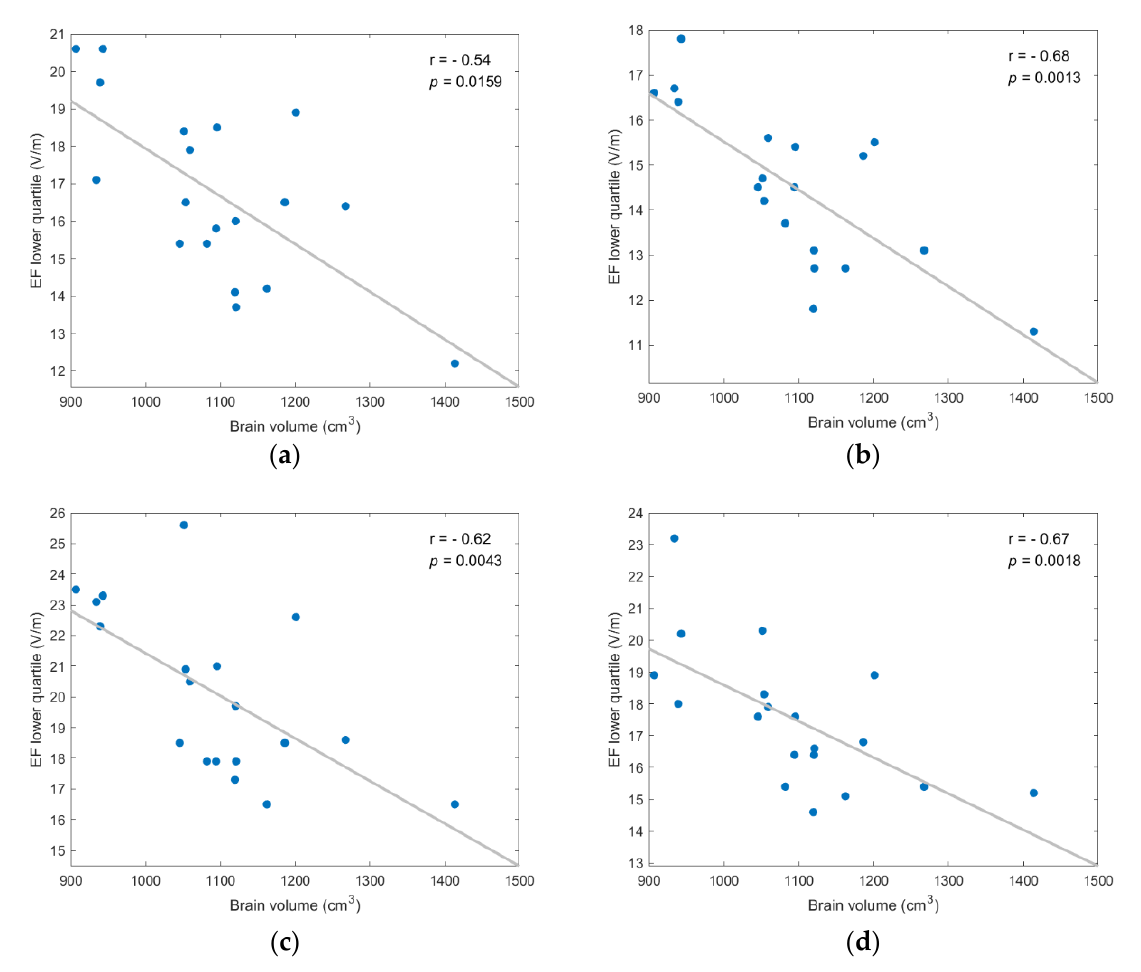
Figure A4. EF lower quartile showed strong, and statistically significant negative, correlation to brain volume for every coil position/model version scenario; ( a ) frontal coil position on anatomical models; ( b ) frontal coil position on homogeneous models; ( c ) central coil position on anatomical models; ( d ) central coil position on homogeneous models.